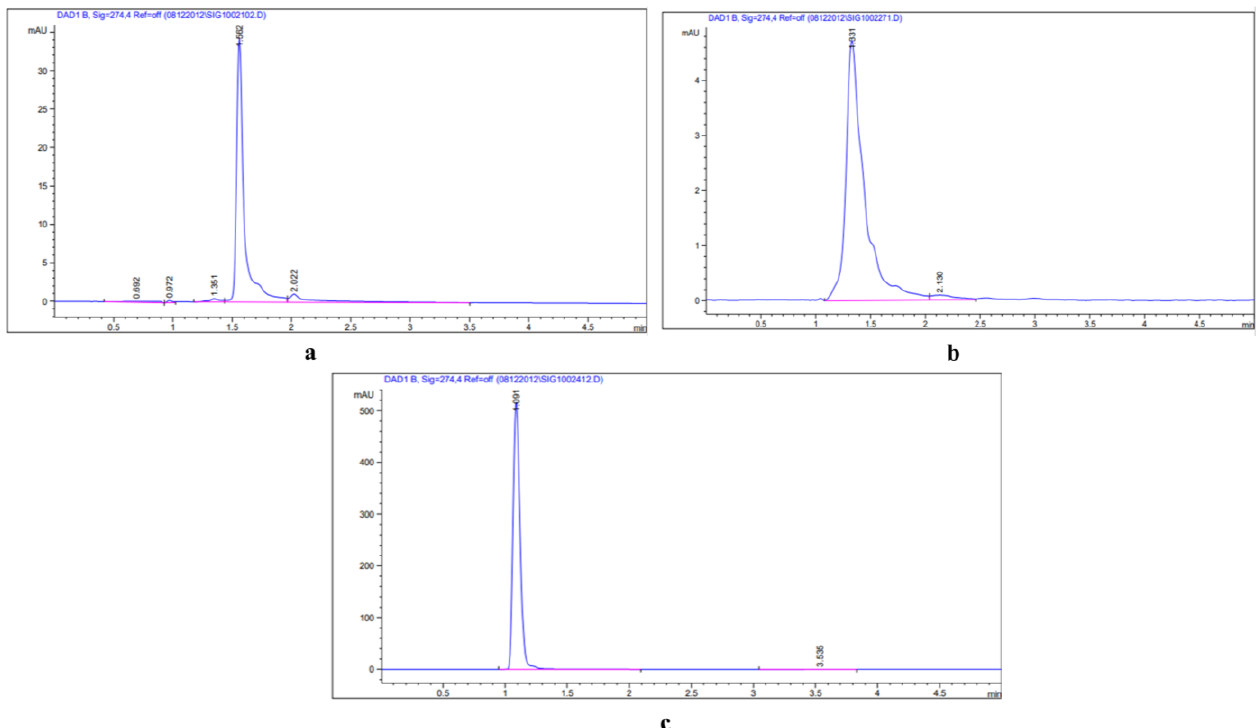
Figure 11. HPLC chromatogram of standard compounds: ( a ) quercetin-3-β-D-glucoside (QBDG); ( b ) luteolin 7-rutinoside; ( c ) p-coumaric acid . Table 2. Content of bioactive compounds in leaves, shoots and roots of E. macrochaetus.